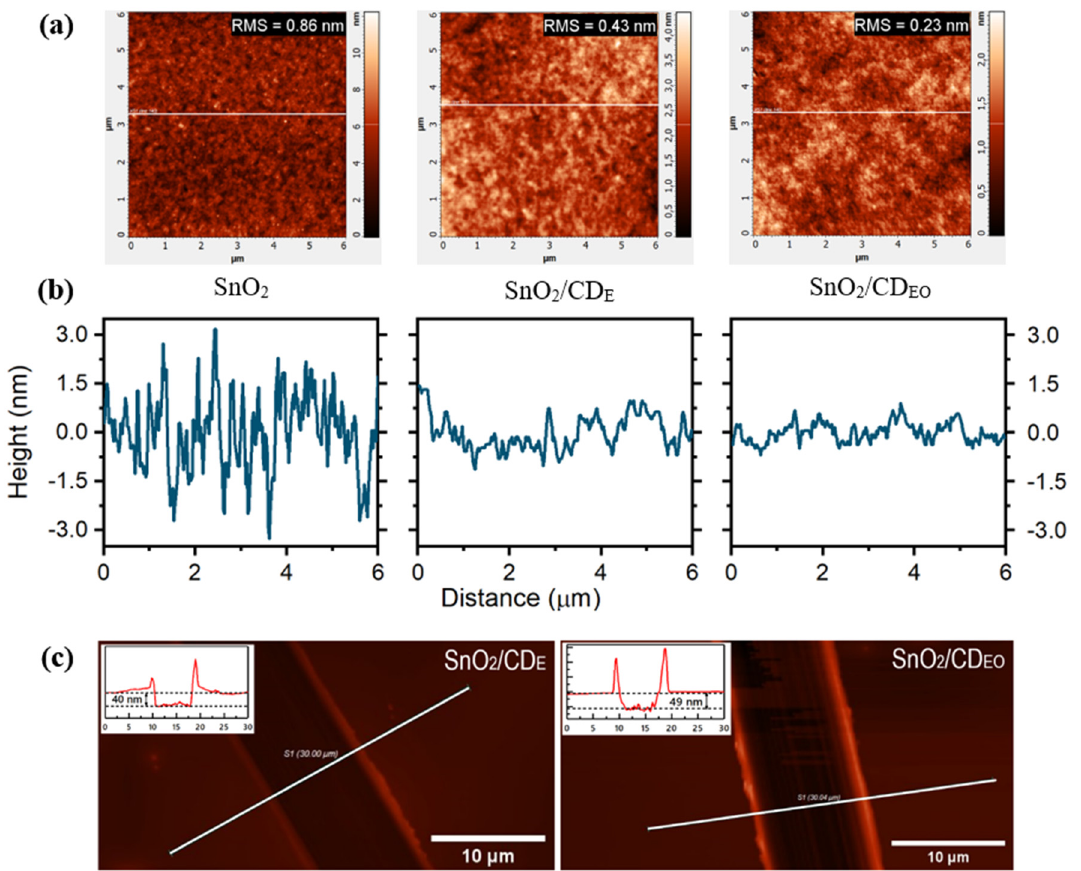
Figure 3. AFM images ( a ) and height profiles ( b ) for ITO/SnO 2 , ITO/SnO 2 /CD E , and ITO/SnO 2 /CD EO films. The calculated RMS of the top layers is specified in the AMF images. The thickness ( c ) of SnO 2 /CD E and SnO 2 /CD EO layers.